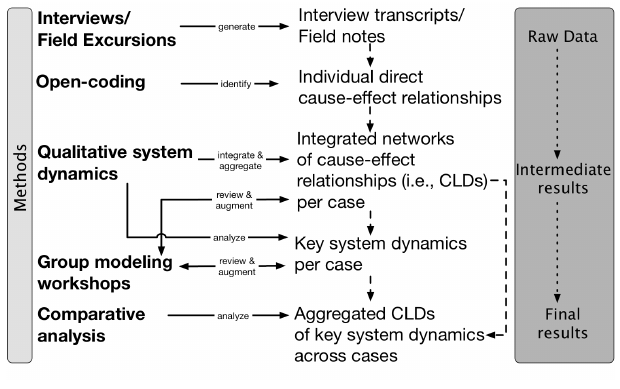
Fig. 3 . Overview of the research process. Note: “CLDs” refer to causal loop